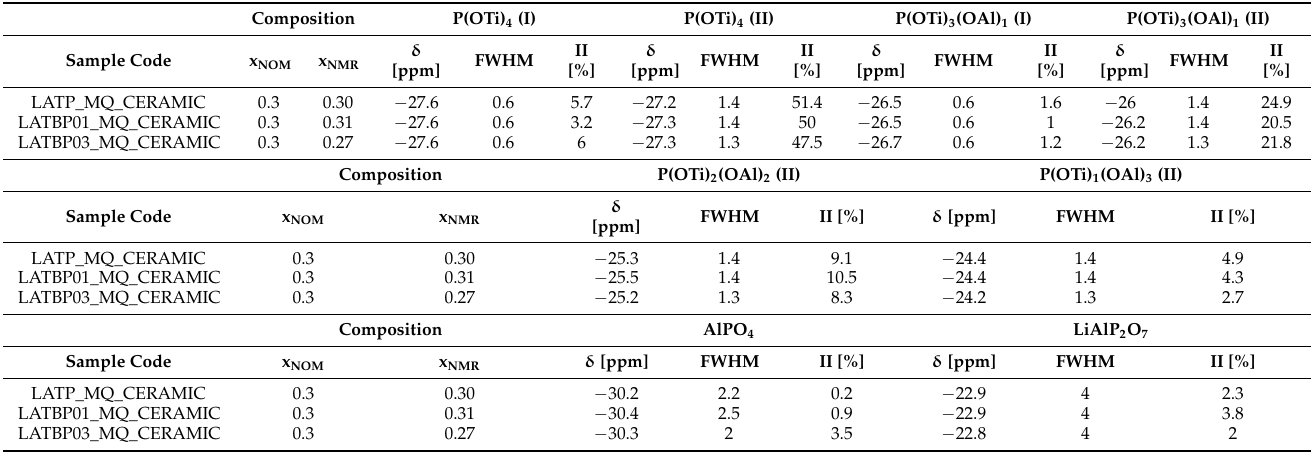
Table 5. Relative integrated intensities (II), full widths at maximum height (FWHM) and isotropic chemical shifts ( δ ) of the line-shapes used to simulate 31 P MAS NMR spectra shown in Figure 11.